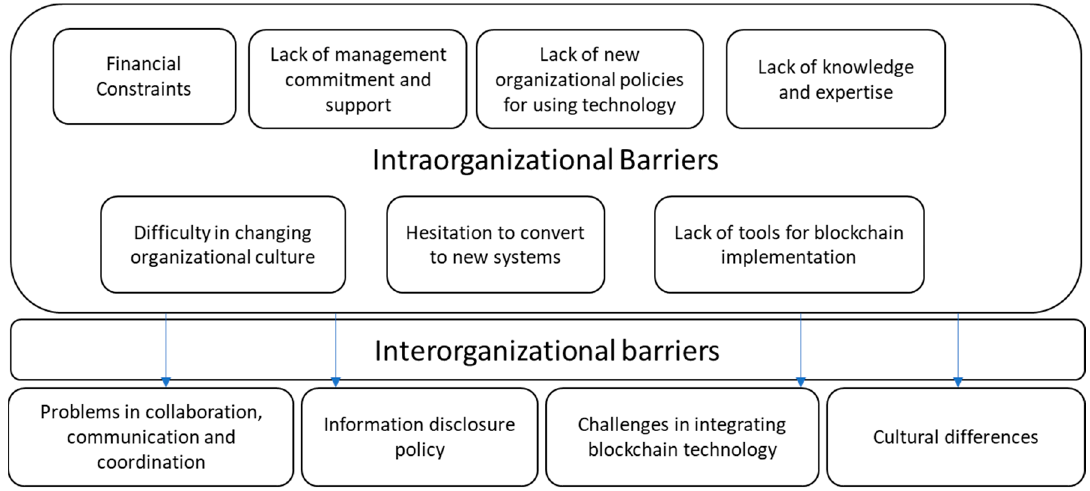
Figure 1. Intra ‐ and interorganizational barriers to blockchain adoption based on [26]. Figure 1. Intra- and interorganizational barriers to blockchain adoption based on